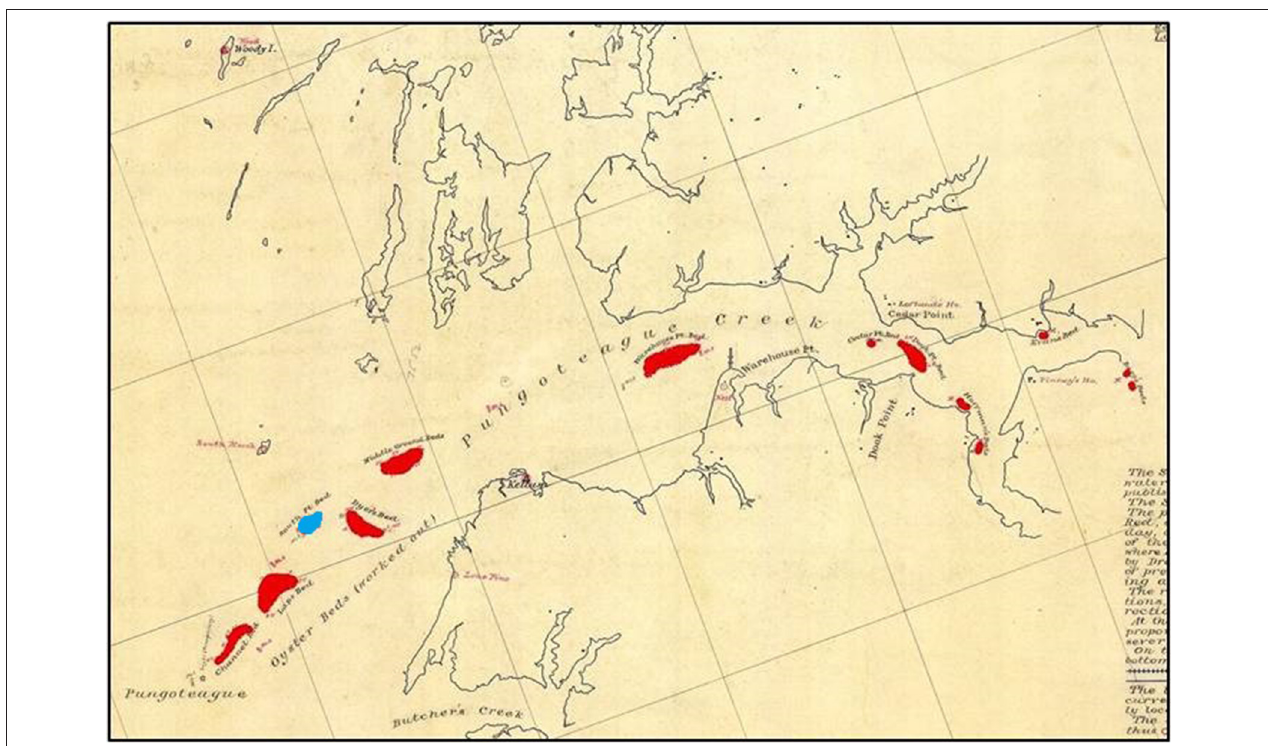
FIGURE 11 | Pungoteague Creek on Bayside Eastern Shore of Chesapeake Bay, showing loss of oyster habitat between 1881 (red areas) and 1981 (blue